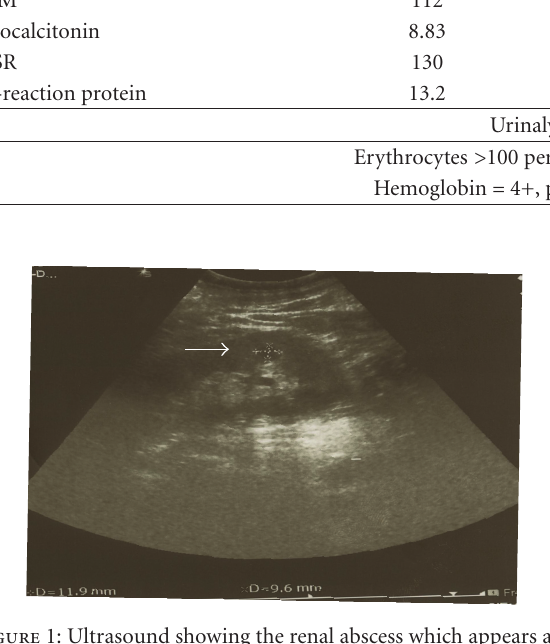
Figure 1: Ultrasound showing the renal abscess which appears as a hypoechoic area 1.19 × 0.96 cm within the cortex of the left